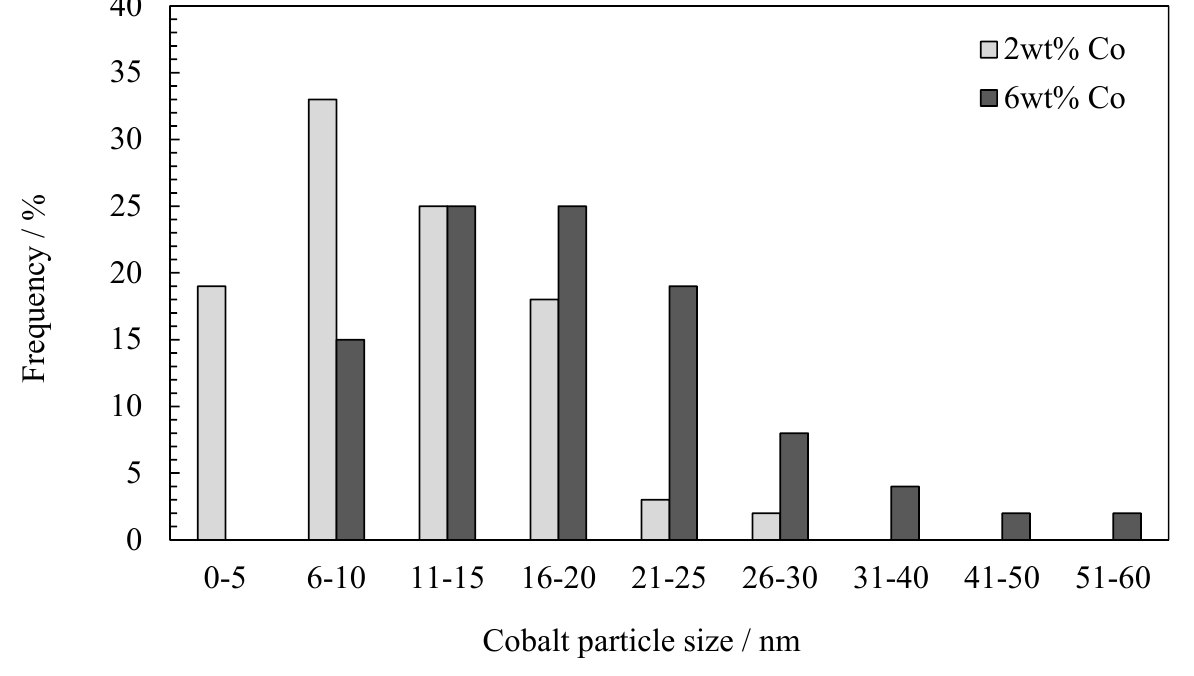
Figure 22. Particle size histogram of the 2 wt% ( ■ ) and 6 wt% ( ■ ) cobalt catalysts. Tavasoli et al. [58] showed that an increase in the cobalt loading (from 8 to 40 wt%) on an Al 2 O 3 support, caused a higher deposition onto the same support surface, result- ing in the agglomeration of cobalt crystal particles, thus forming larger clusters. Larger clusters were associated with weaker metal-support interactions, resulting in improved reducibility [75,76], and thus generating more active sites (a larger catalytic surface area) for FTS reactions. It was also reported that larger clusters may reduce steric hindrance for dissociative adsorption of CO [58], which could promote chain growth monomer formation. The effects of a higher cobalt loading on the FTS performance factors in this work are in agreement with the literature mentioned above [58,75,76]. That is, the larger cobalt particles of the 6 wt% Co catalyst corresponded to higher C 1 –C 3 hydrocarbon yields. It also improved chain growth, as indicated by propylene production, which was absent for the blank and 2 wt% Co catalysts studies. In addition to the cobalt particle sizes, TEM also revealed the presence of carbonaceous Figure 23. This was an unexpected finding as CNTs are not synthesized in conventional FTS due to low temperature operation. The only known connection between CNTs and conventional FTS in the literature is the use of CNTs as catalyst supports [77–86]. CNT synthesis in this work is suggested to occur through similar mechanisms to that in thermal chemical vapor deposition (CVD) and/or plasma enhanced chemical vapor deposition (PECVD), as there seem to be some similarities between these processes and their